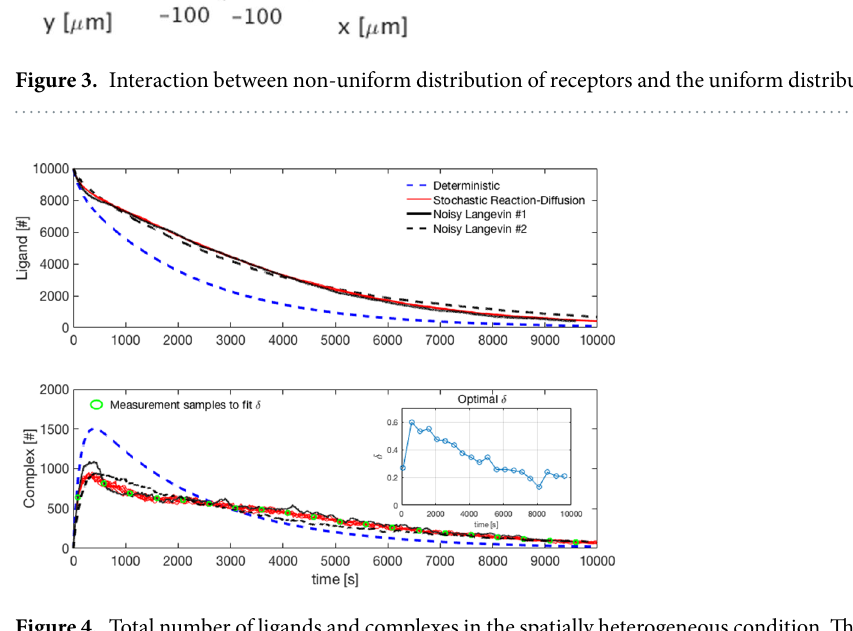
Figure 4. Total number of ligands and complexes in the spatially heterogeneous condition. The time histories of the ligand and the complex obtained from the ordinary differential equations. The 10 stochastic realisations of the reaction-diffusion simulation are carried out using MesoRD and the green circles are the mean values of the MesoRD simulation results (considered as surrogate data points from wet-lab experimental measurements). The new Langevin equation with the optimal δ obtained by solving a minimisation problem provides a highly accurate simulation of the molecular time histories in less than one second (Noisy Langevin #1), compared with 38 minutes to compute one reaction-diffusion simulation using MesoRD. The inset shows the corresponding time history of δ , which is clearly able to capture the effects of spatial heterogeneity. Less accurate but still reasonable matched trajectories with even lower computational overheads are obtained using a random sampling of δ between upper and lower bounds that can be calculated from experimental measurements (Noisy Langevin